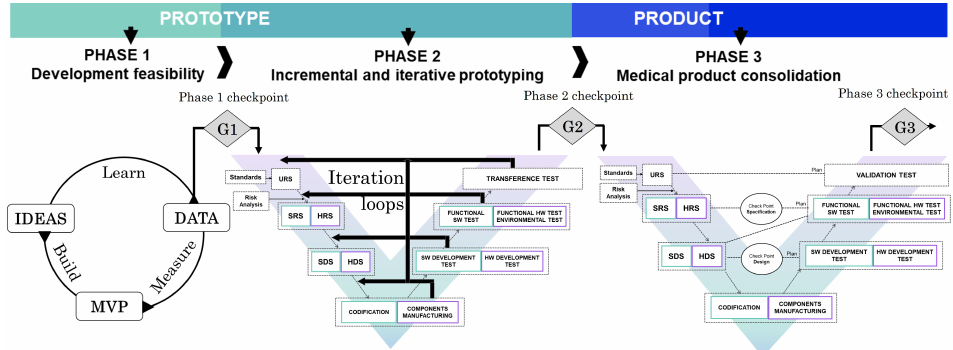
Figure 9. Stages of the proposed